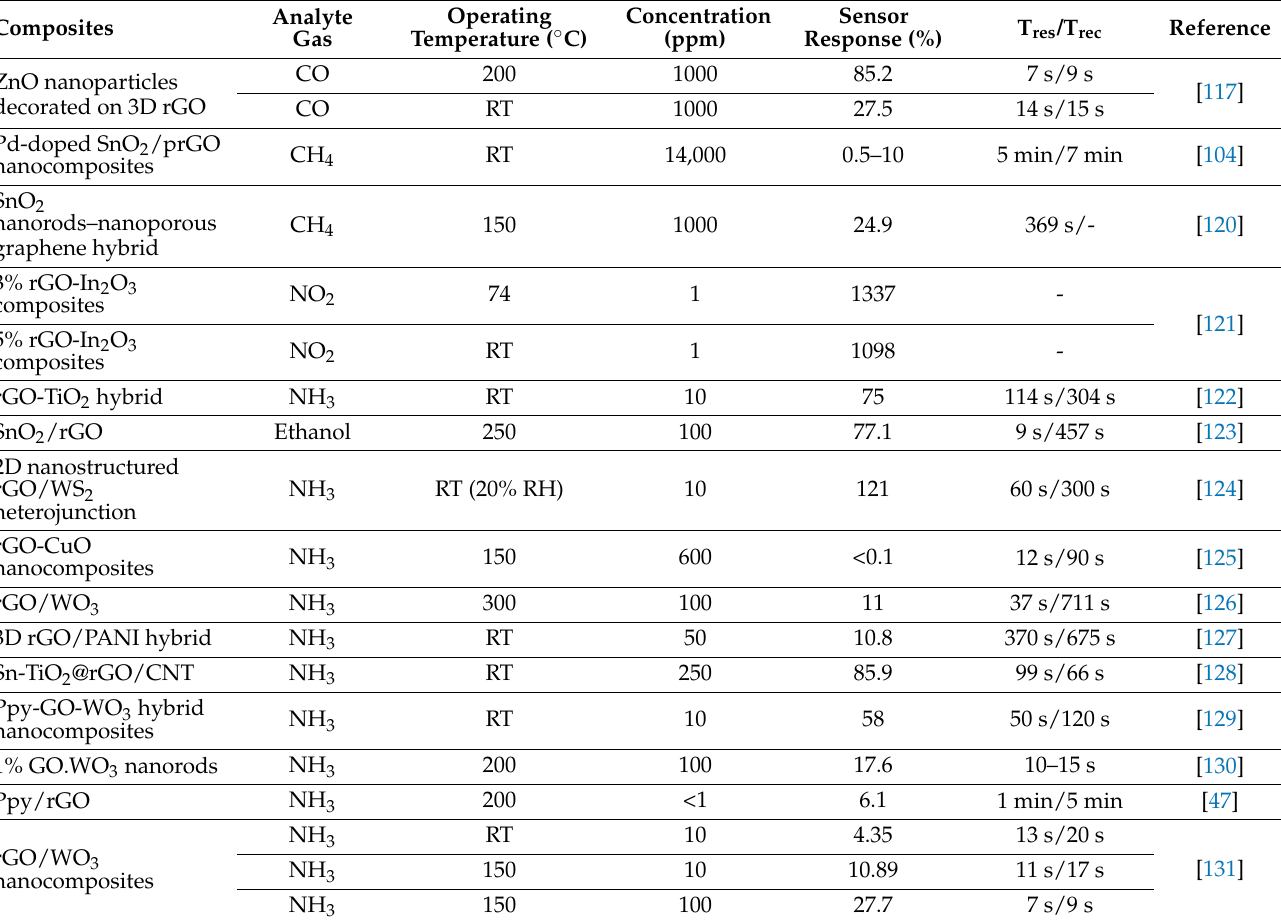
Table 5. Summary of previous studies of graphene-based materials synthesised using the hydrother- mal/solvothermal